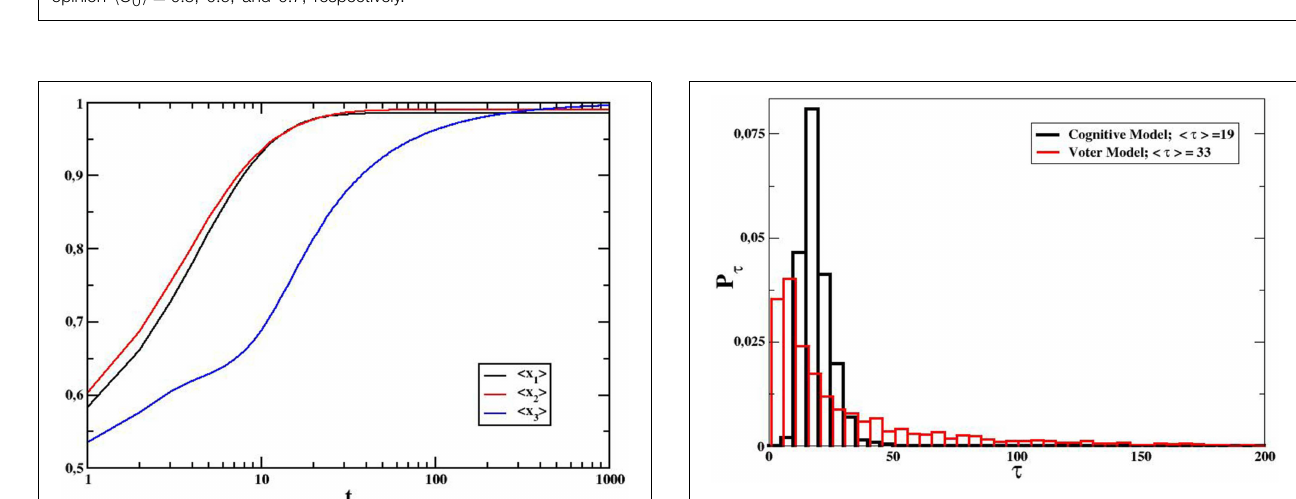
FIGURE 6 | Behavior of the opinion for a system of N = 100 individuals on a totally connected graph; continuous opinion. Averages over 2000 independent realizations. (A) Time evolution of the average opinion for four different initial conditions (from top to bottom of the figure: h O 0 i = 0 . 75 , 0.6, 0.5, 0.45, respectively), average over 2000 independent realizations. (B–D) Evolution of the opinion of each agent during a single realization, for initial average opinion h O 0 i = 0 . 3 , 0 . 5 , and 0 . 7 , respectively.